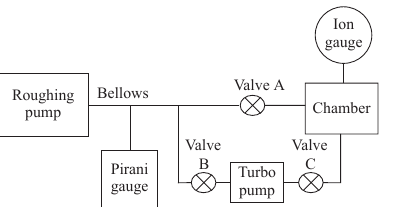
Figure 16. Vacuum system used in the experiment. In the first stage of the experiment, valves B and C are closed and the chamber is pumped directly using the roughing pump. In the second stage, valve A is closed and the chamber is pumped by the turbo pump in series with the roughing